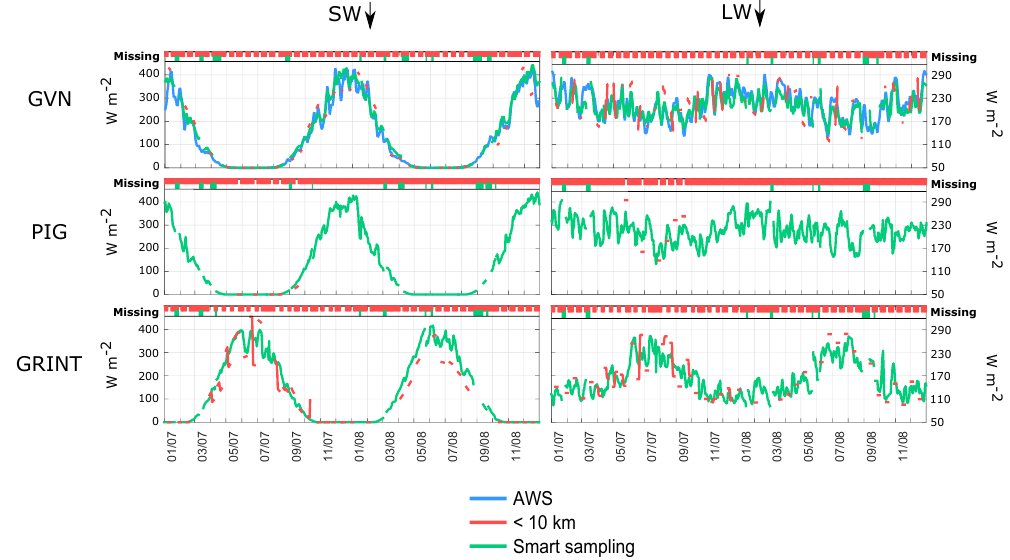
Figure 13. Five-day moving average SW ↓ and LW ↓ fluxes for GVN, PIG, and GRINT (January 2007–December 2008). The available AWS observations at GVN are shown in blue. The limited-distance sampling <10km from the POI (red) shows significantly more data gaps compared to the smart sampling approach (green), while the agreement with AWS observations is also better for the smart sampling